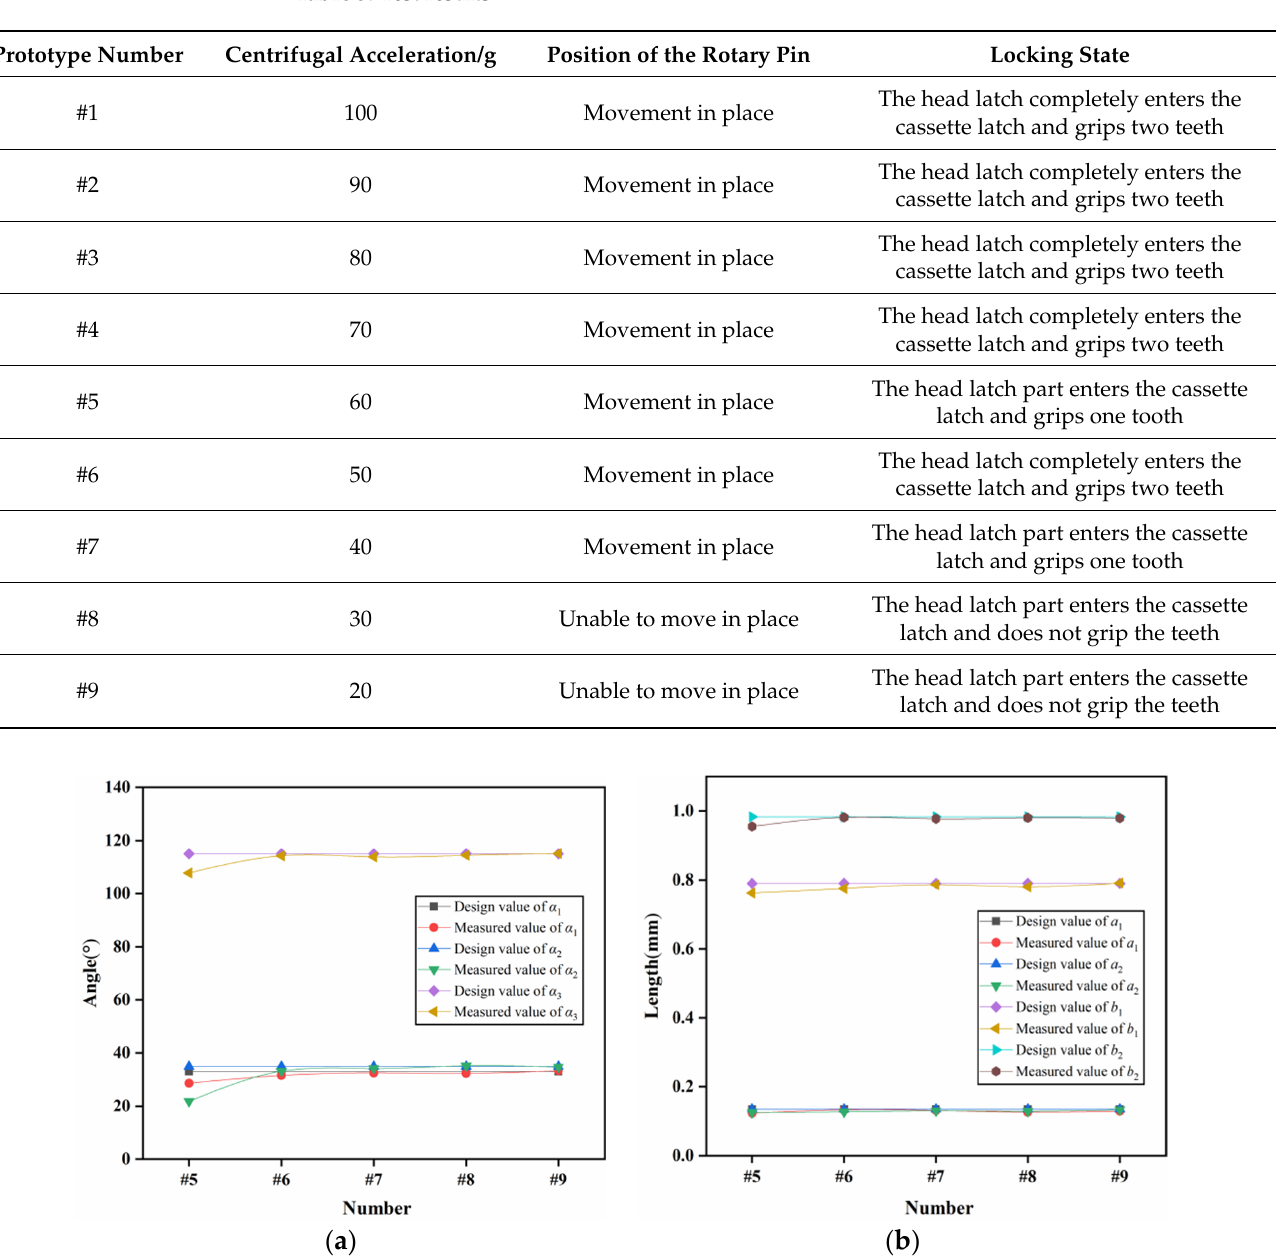
Figure 26. Results of comparison. ( a ) Characteristic angle; ( b ) Characteristic length.